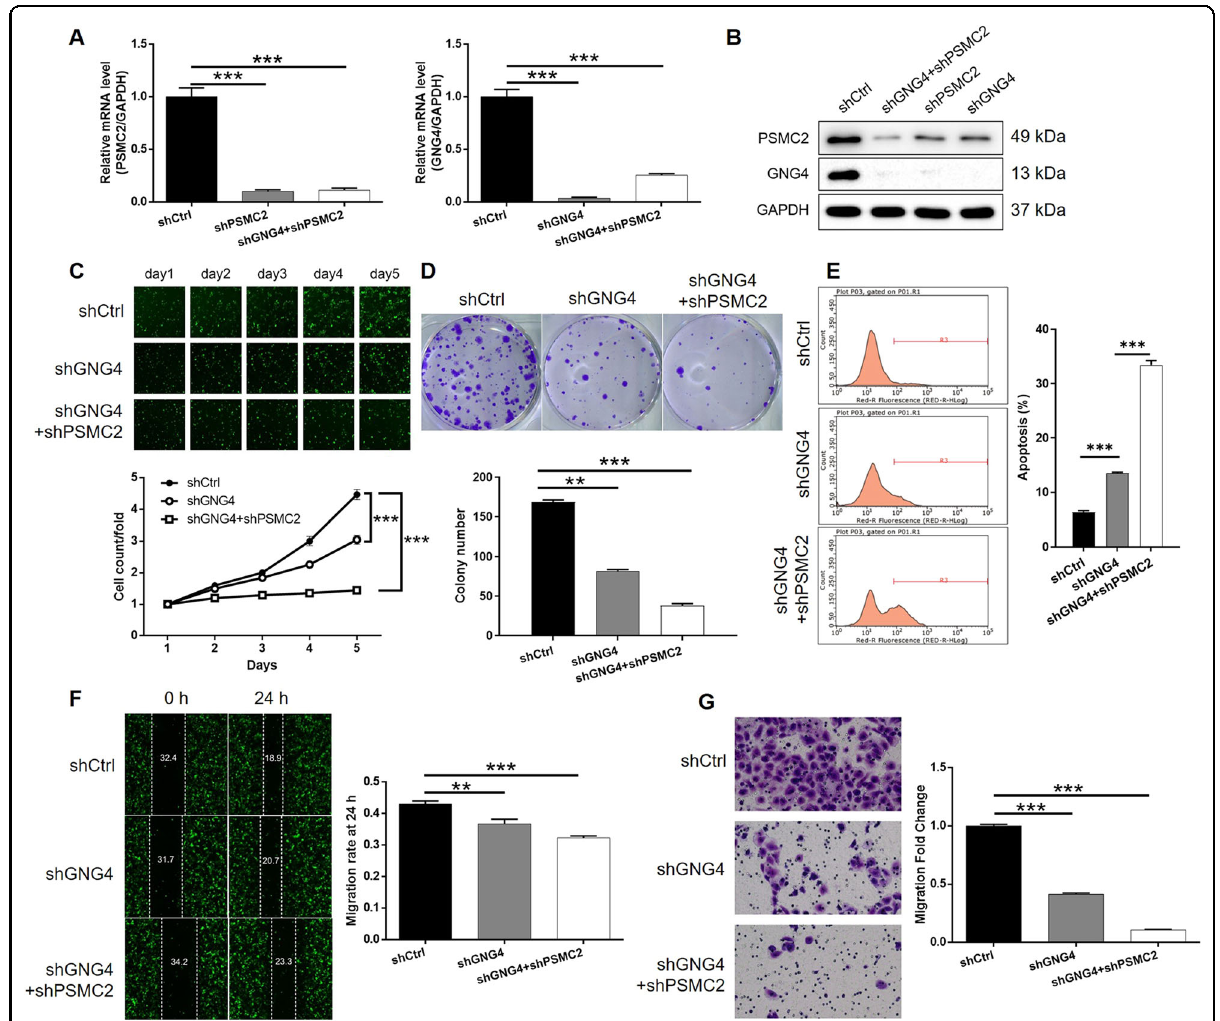
Fig. 4 Knockdown of PSMC2 deepens the effects on GBC-SD cells by GNG4 knockdown. A , B The expression of PSMC2 and GNG4 in GBC-SD cells transfected with shCtrl, shGNG4, and simultaneous shPSMC2 and shGNG4 were detected by qPCR ( A ) and western blotting ( B ). Cell models were subjected to the detection of cell proliferation by Celigo cell counting assay ( C ), colony formation ( D ), cell apoptosis ( E ), cell migration by wound-healing assay ( F ) and cell migration by Transwell assay ( G ). The representative images were selected from at least 3 independent experiments. Data were shown as mean ± SD. ** P < 0.01, *** P <